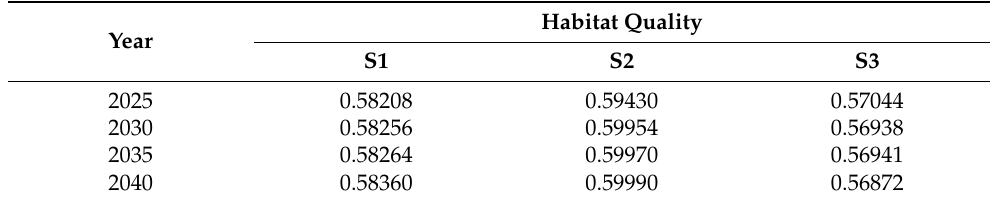
Table 14. Habitat quality of the Yellow River Basin under different scenarios in 2025, 2030, 2035, and 2040.